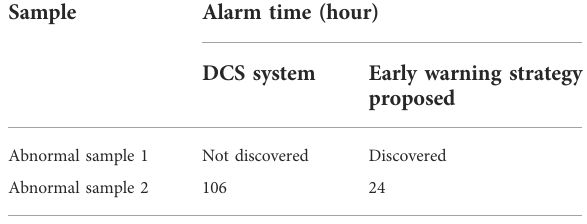
TABLE 4 Comparison between DCS system and the early warning strategy proposed in this